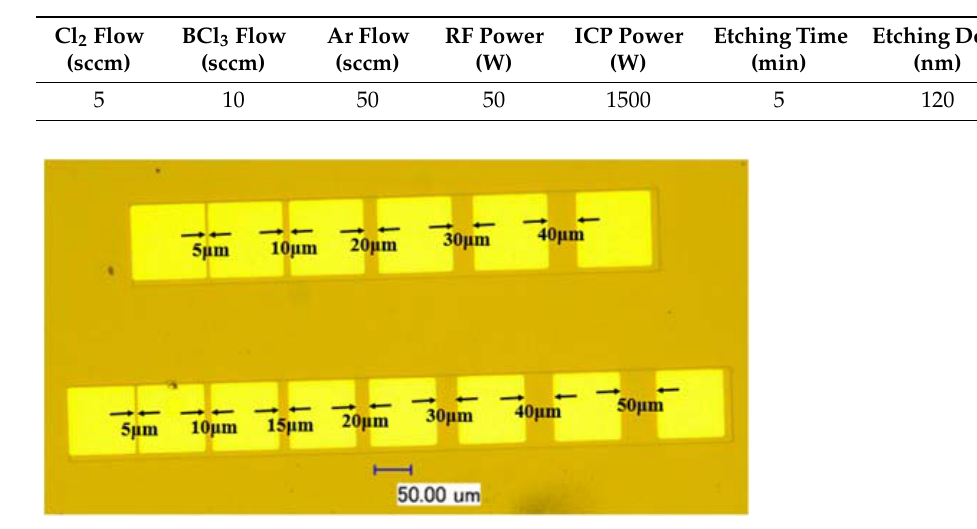
Table 1. Main parameters of the ICP etching process.